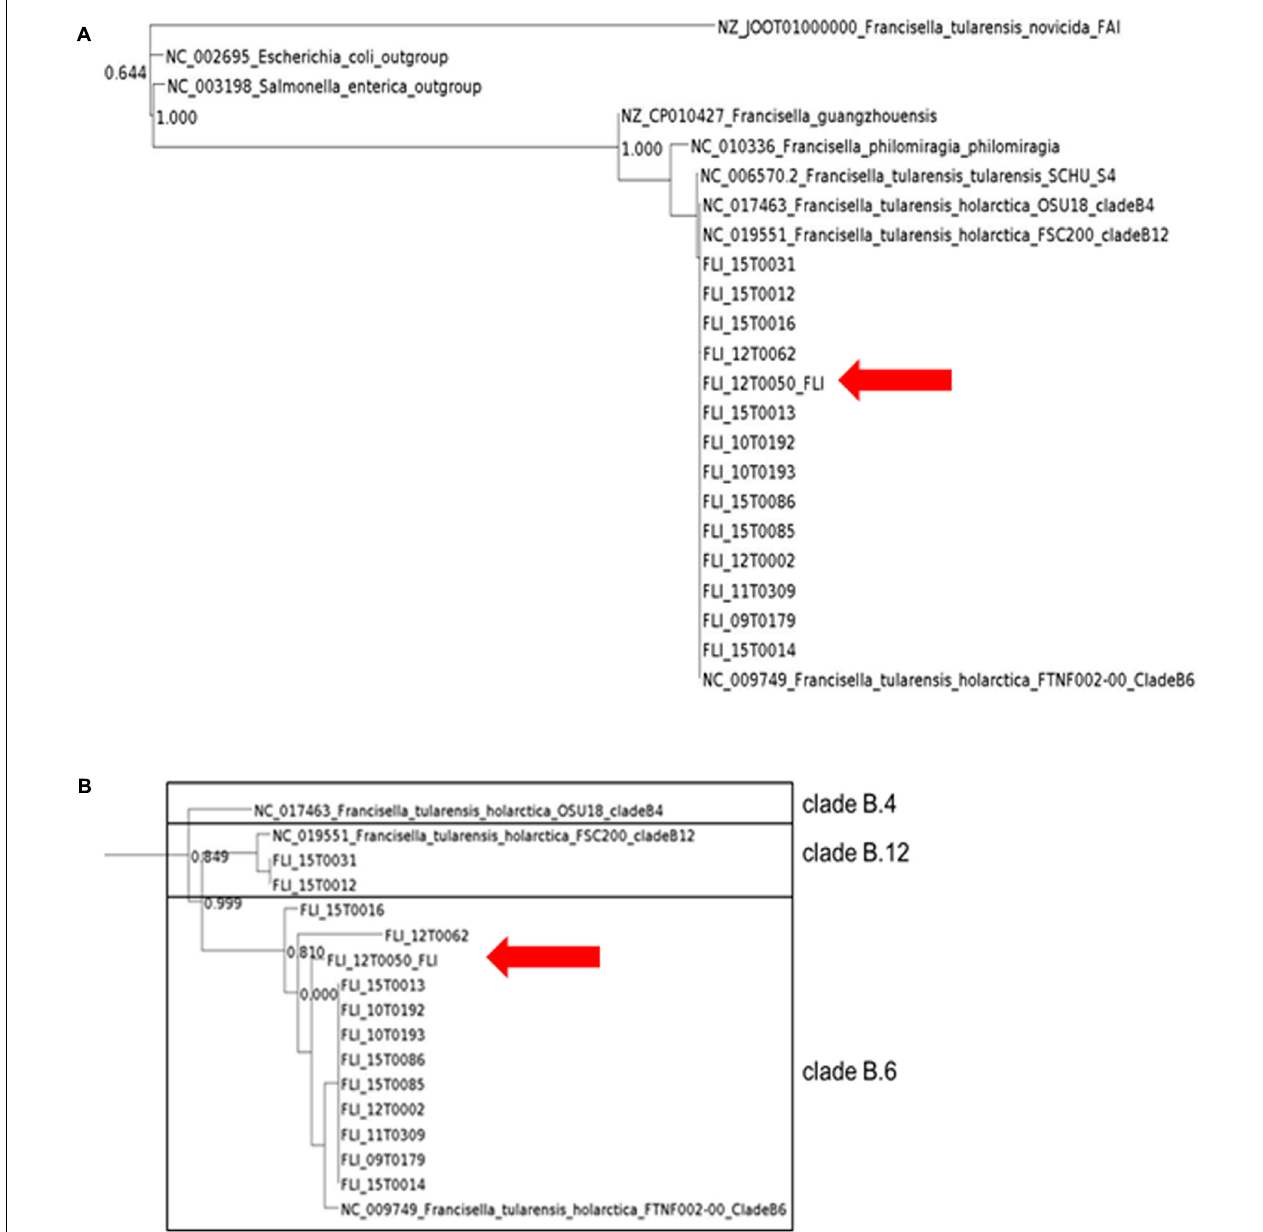
FIGURE 3 | PhyloPhlAn analysis of all Francisella isolates using amino acid sequences of more than 400 proteins. The graphic scale equals 2.0 amino acid differences in the overview (A) and in the detailed view with F. tularensis subsp. holarctica, the graphic scale equals 0.001 amino acid difference (B)